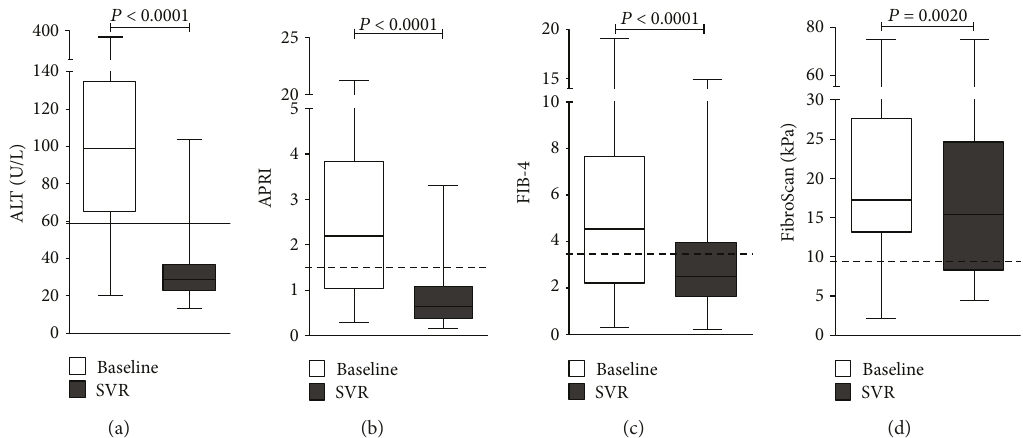
Figure 3: Evaluation of noninvasive hepatic parameters in chronic hepatitis C patients after DAA antiviral therapy. (a) ALT levels, (b) APRI and (c) FIB-4 indexes, and (d) FibroScan were decreased in SVR. Line: upper limit of normal values. Dashed lines: upper limit of F2 category. Statistical signi fi cance was assessed by Wilcoxon test or paired t -test ( P < 0 05 Table 3: Expression pattern of cytokines in chronic hepatitis C patients with di ff erent liver disease status.